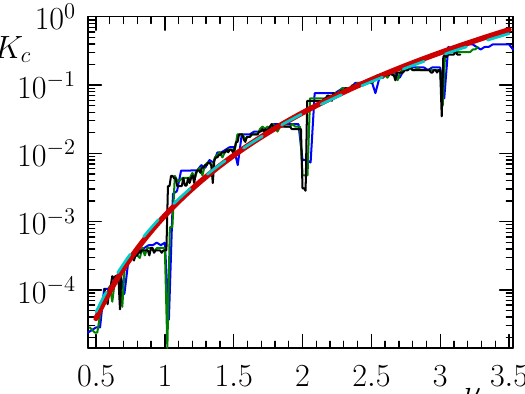
Figure 3. Dependence of the Aubry transition critical threshold K c on the atomic density ν shown for different chain lengths L = 34 (blue curve), 55 (green curve) and 89 (black curve). The red full curve shows the theoretical dependence (3), the dashed cyan curve shows the fit with K c = 0.0137 ( ν / ν g ) α , ν g = 1.618... and α = 4.82 ±